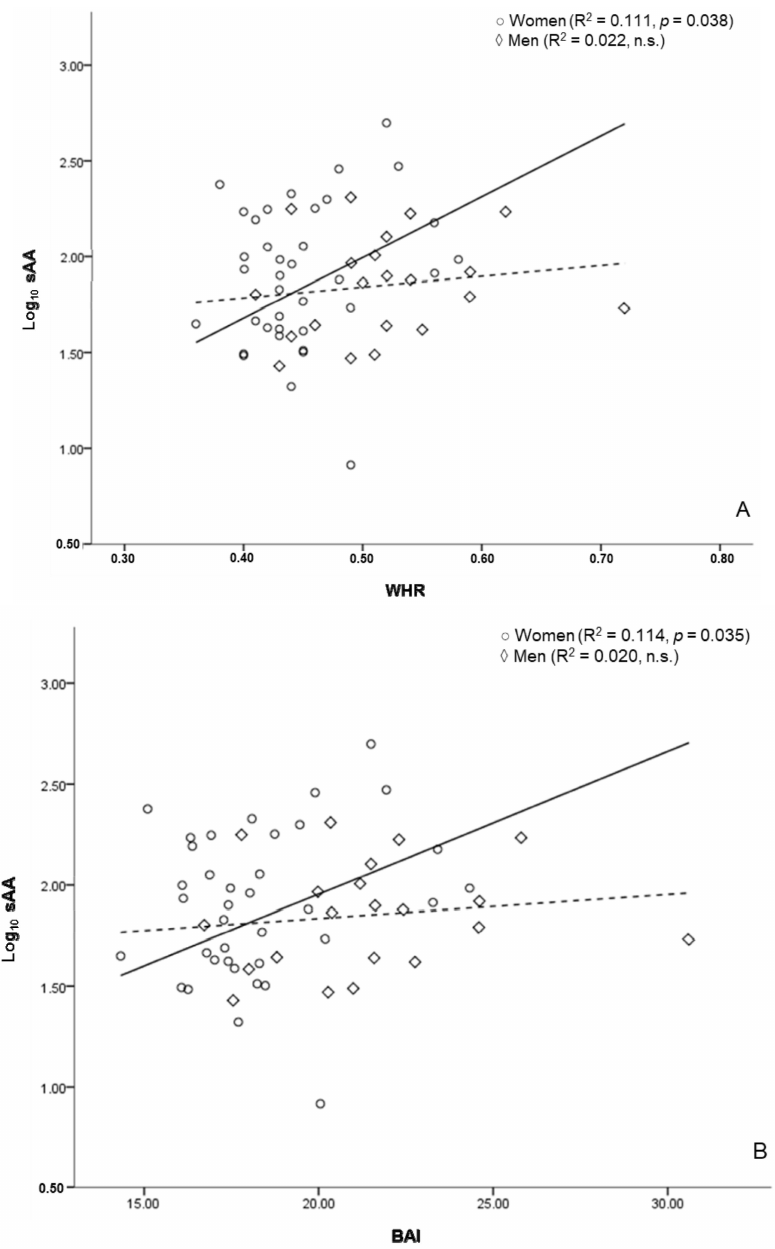
Figure 3. Salivary alpha-amylase and anthropometric markers of cardiovascular risk. Association of the log 10 transformed sAA values of Waist-to-Hip Ratio ( A ) and Body Adiposity Index ( B ). The straight line represents the line of best fit of the subjective category. The dotted line represents the line of best fit of the behavioural